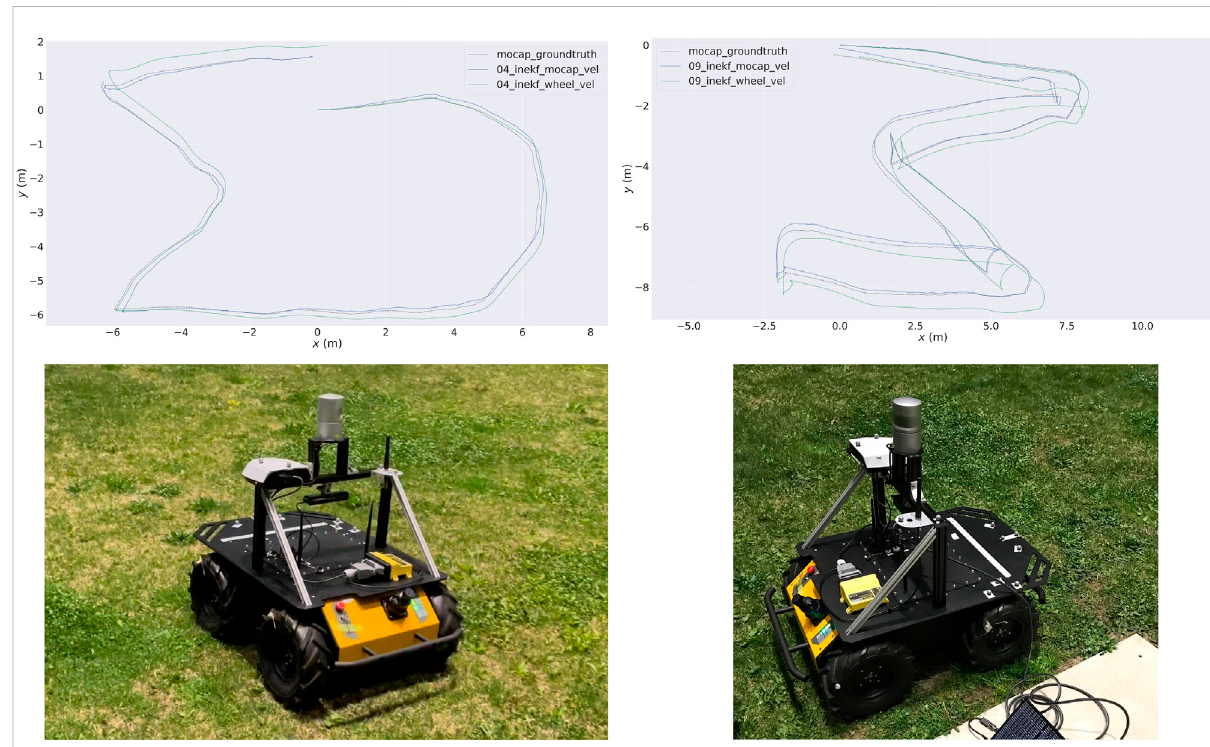
FIGURE 7 Top:Twosequences oftrajectories recordedattheUniversityof Michigan MAirmotioncapture facility. The green linesare theInEKFestimated trajectoriesusingvelocityestimatedfromthewheelencoders,andthebluelinesaretheInEKFresultsusingvelocityfromthemotioncapturesystem. Bottom: The robot setup. The ground of the facility is planted with natural